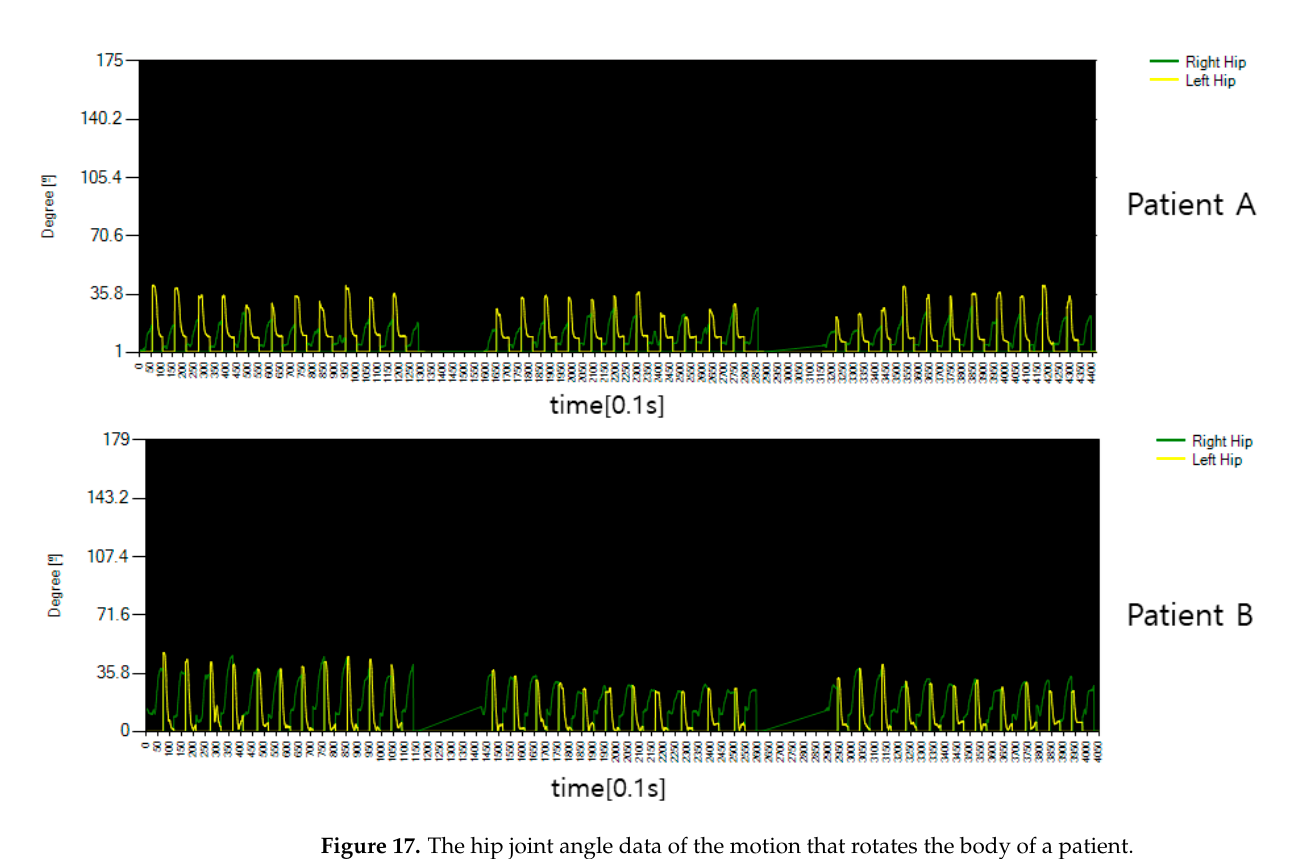
Figure 17. The hip joint angle data of the motion that rotates the body of a patient.